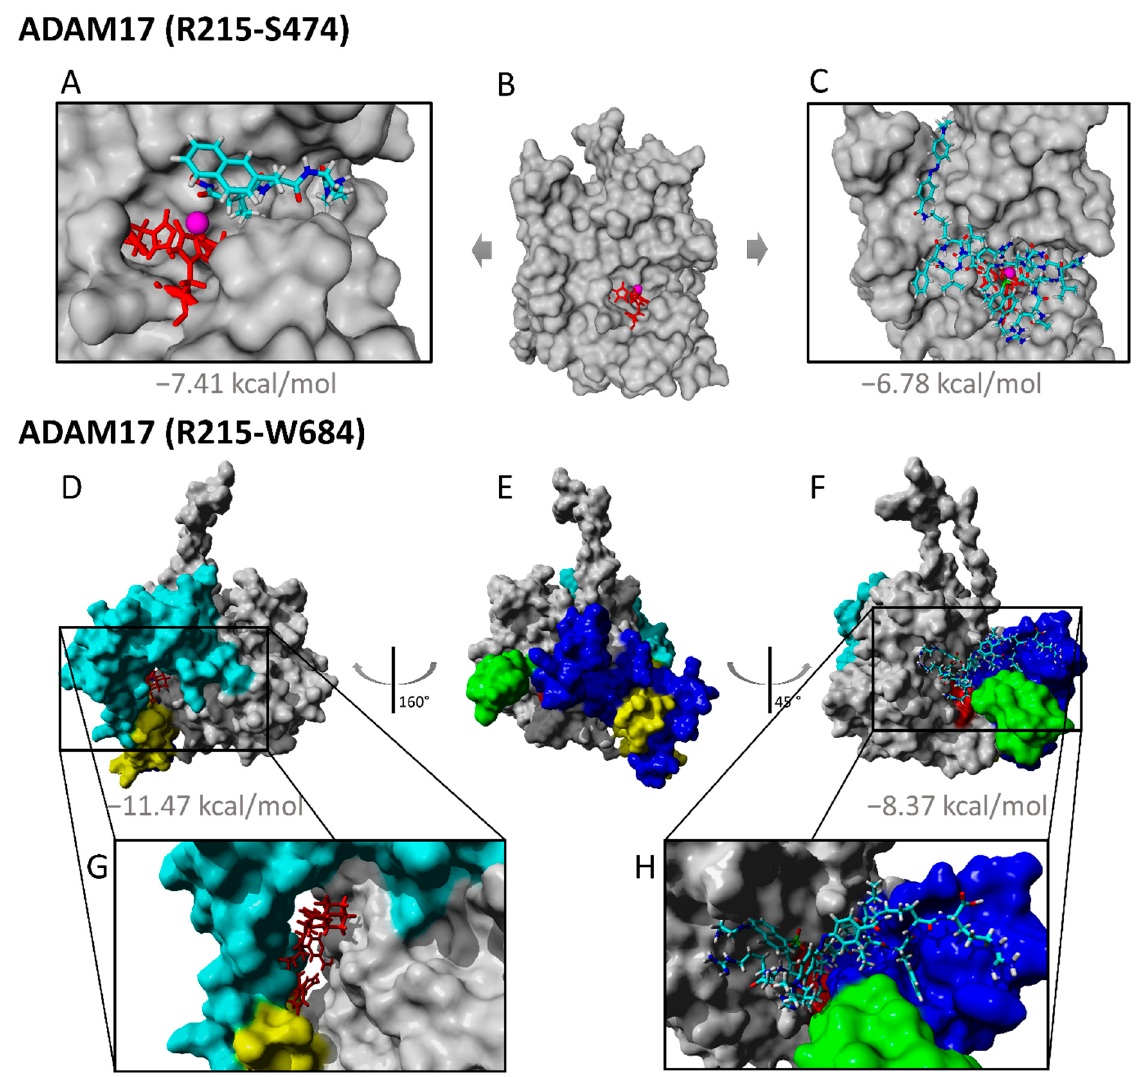
Figure 5. Molecular docking of substrate and inhibitors with ADAM17 catalytic domain (R215 – S474) and ADAM17 extracellular domain (R215–W684). The catalytic domain ( B ) was docked with TAPI-1 ( A ) and secretase substrate II ( C ), which both bind to the substrate-binding site. TAPI-1 binds with its hydroxamate group to zinc ion (magenta), bound by the Histidines H405, H409, H415 (red). Binding energies are given below each docking pose (grey). Extracellular domain of ADAM17 ( E ) was docked with exosite inhibitor ( D , G ) and secretase substrate II ( F , H ), where. Black boxes mark zoomed regions ( D – F , H ). Exosite inhibitor binds on the opposite side of substrate binding site between the disintegrin domain (cyan), the cys-rich (yellow) domain and the catalytic domain (grey surface), while substrate binds partially to the blocked binding site. Zinc is hidden behind the membrane-proximal domain (blue) and helix domain (green).